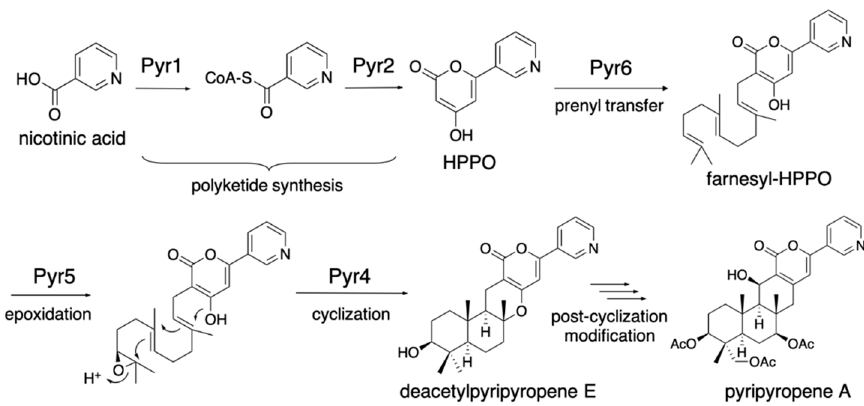
Figure 2. Biosynthetic pathway of pyripyropene A.